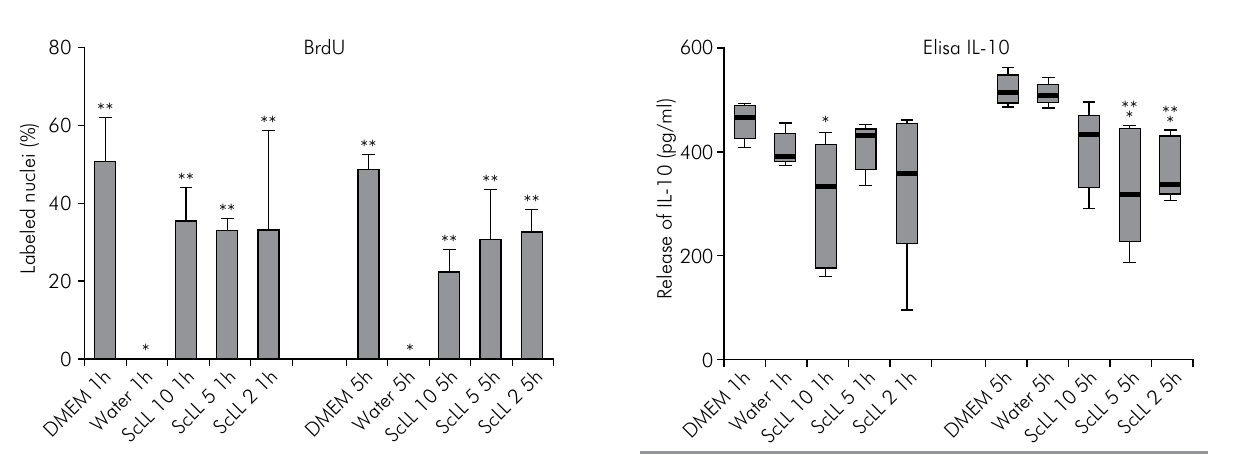
Figure 3. Comparison of cell proliferation percentage at 1 and 5 h. Statistical significance was determined using a one-way ANOVA and Dunnet’s test. *p < 0.05 compared with positive control (DMEM). **p < 0.05 compared with negative control (tap water).